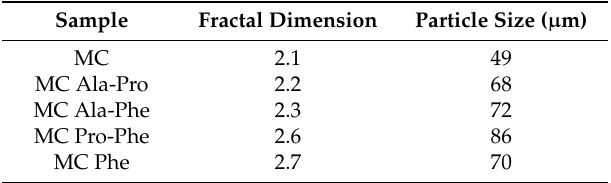
Table 2. Physical properties of cellulose samples. Fractal dimension as determined by small angle X-ray scattering (SAXS) data under the Porod law, and particle size as determined by light scattering.